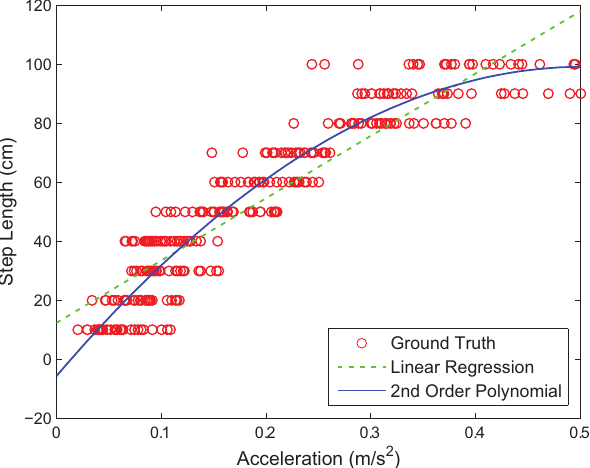
Figure 3. Relationship between the step length and acceleration magnitude obtained from the ground truth step data. The relationship is model by the polynomial regression or linear